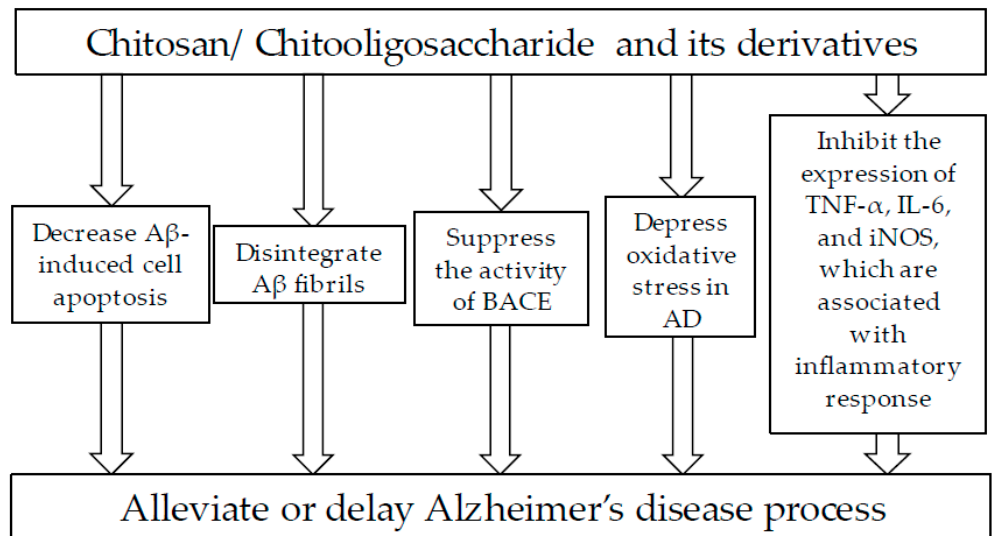
Figure 2. The neuroprotective effect of COS against Alzheimer’s disease.